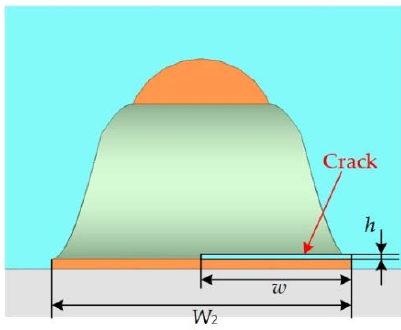
Figure 6. Parameterized model of the solder joint with the crack .